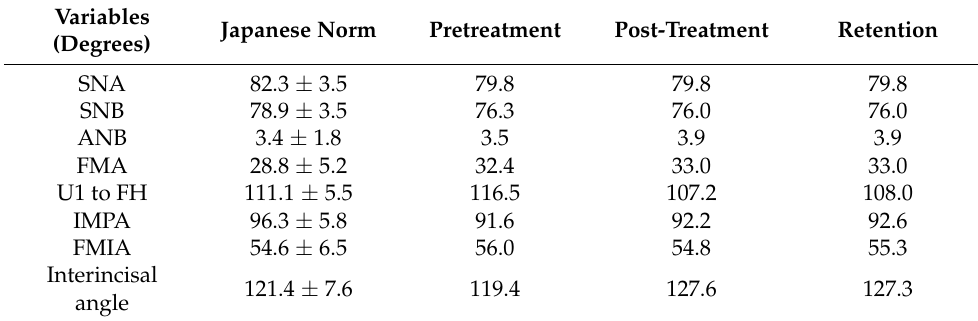
Table 1. Cephalometric